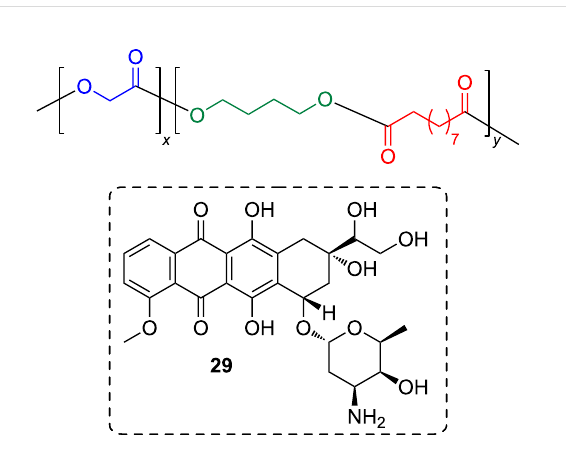
step procedure has been used, an initial polymerization to achieve oligomers followed by a second step at higher tempera- ture and/or lower pressure. The synthesis of oligomers and short telechelics (oligomers with functionalized ends) avoids much of the problems and afford better reaction rates.